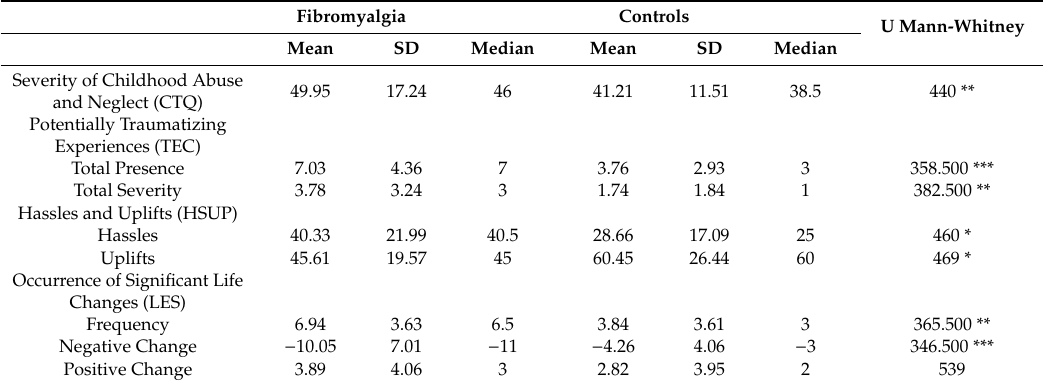
Table 1. U Mann-Whitney Test results for the significant di ff erences between groups in the frequency and impact of traumatic experiences, life events and daily situations. Fibromyalgia